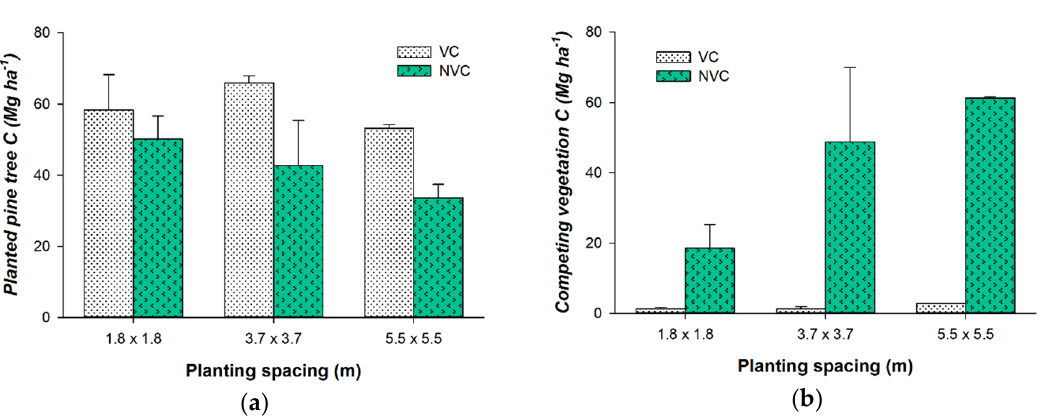
Figure 2. 28-year-old aboveground vegetation carbon (mean + sd) for ( a ) planted trees and ( b ) competing vegetation grown under overstory planted at three levels of spacing and competing vegetation control (VC) and non-control (NVC) at the Challenge Experimental Forest, California.